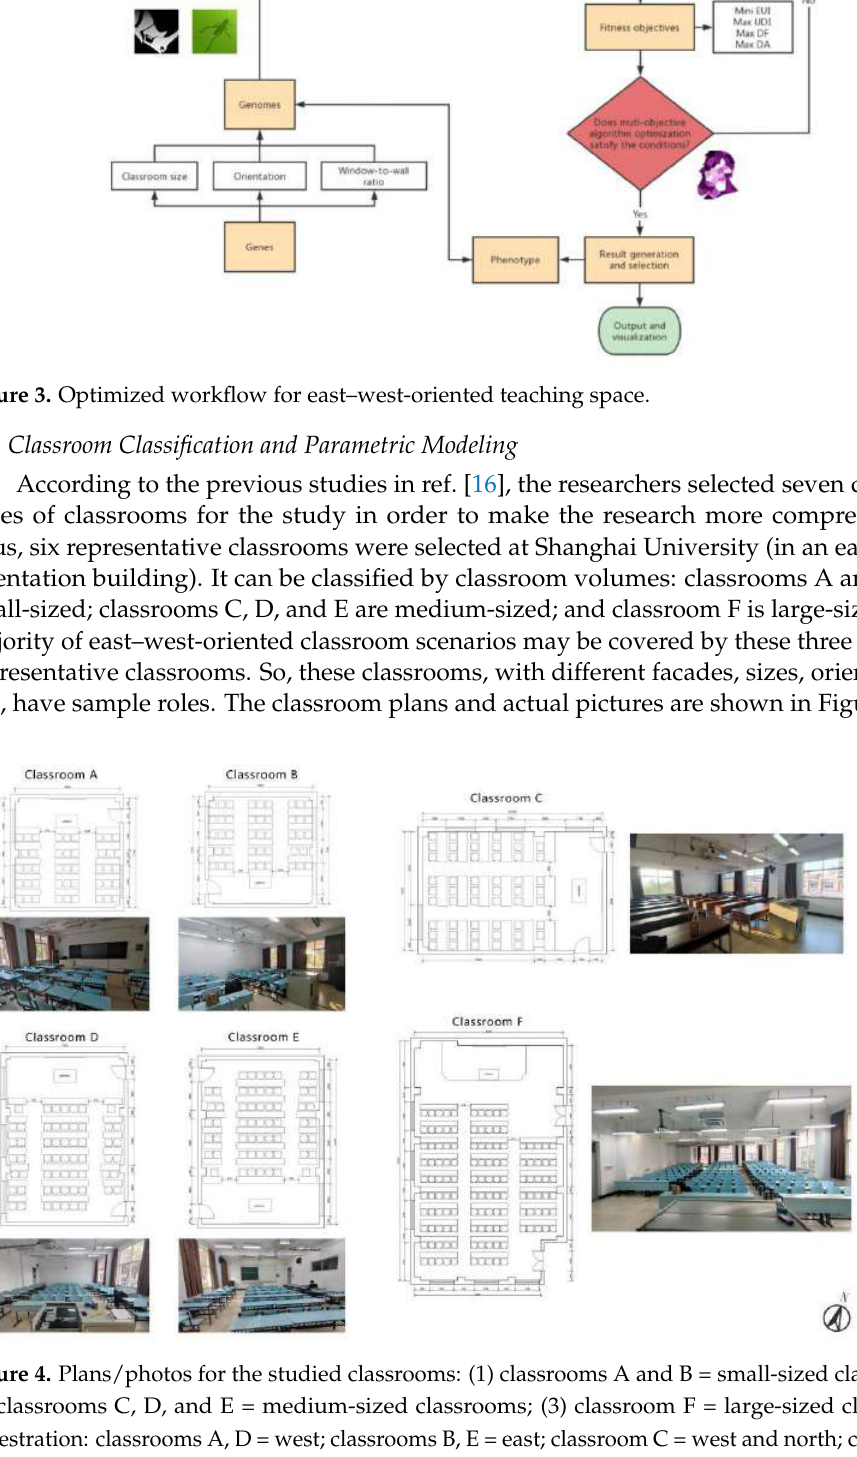
Table 1. Characteristics of the investigated classrooms.